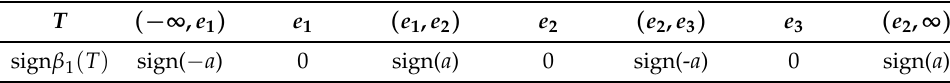
Table 1. The sign of β 1 ( T ) when there are three roots e 1 , e 2 , e 3 .